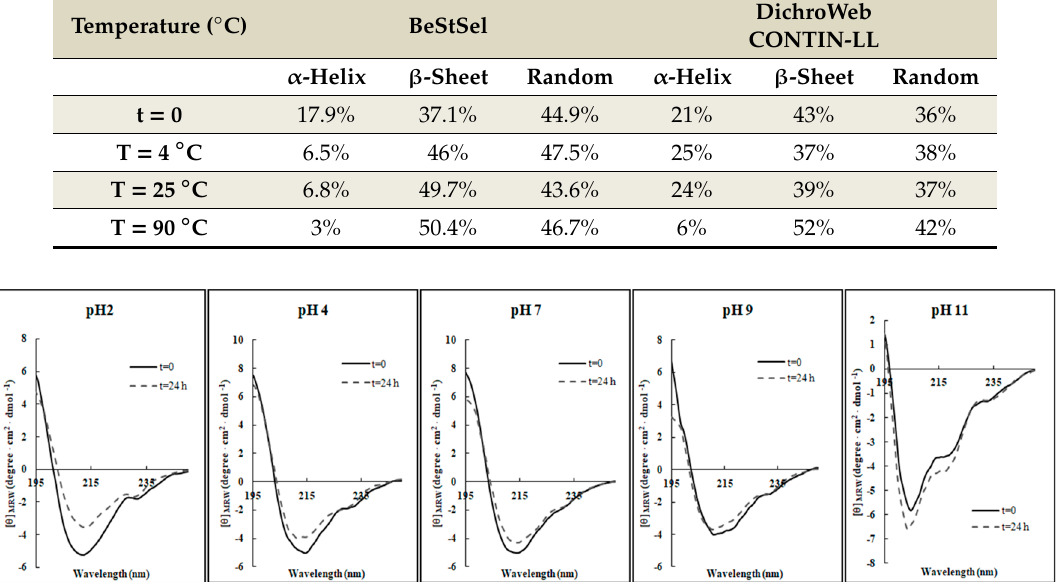
Figure 3. E ff ect of pH on the secondary structure of RiLK1. Far-UV CD spectra were obtained by Figure 3. Effect of pH on the secondary structure of RiLK1 . Far ‐ UV CD spectra were obtained incubating the peptide (0.1 mg / mL) in bu ff ers at di ff erent pHs for 24 h at 25 ◦ C, and in the presence of by incubating the peptide (0.1 mg/mL) in buffers at different pHs for 24 h at 25 °C, and in the SDS at a final concentration of 3 presence of SDS at a final concentration of 3 mM.